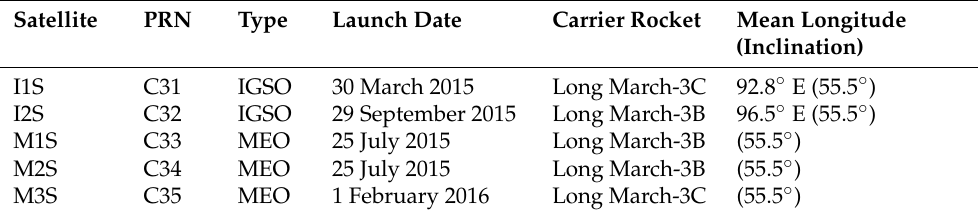
Table 1. The status of the experimental BDS-3 satellites (February